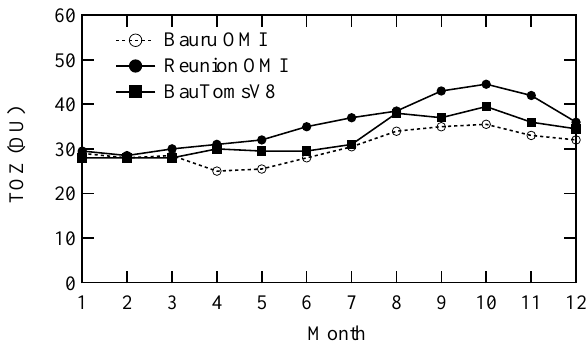
Fig. 15. Tropospheric ozone column in OHP derived from OMI (open circles), ECC sondes (filled circles), and TV8 climatology (filled squares).